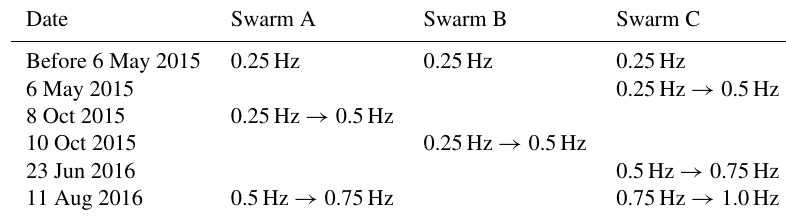
Table 1. The increases of L2 phase-locked loop bandwidth of Swarm